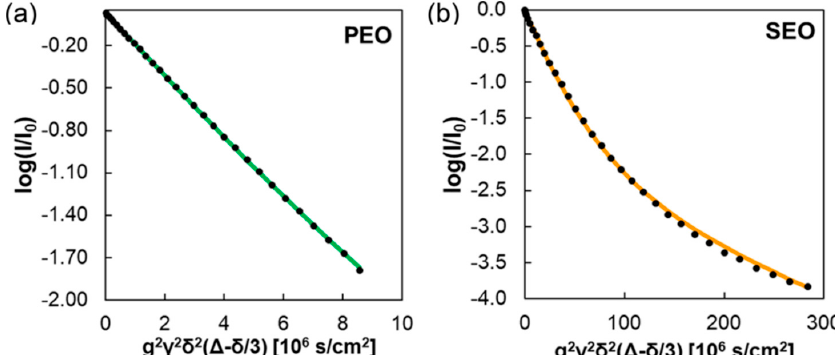
Figure 6. PFG-NMR signal attenuation of 19 F seen in ( a ) PEO(5)/LiTFSI at r = 0.06 and ( b ) SEO(16 − 16)/LiTFSI at r = 0.18 [65]. Reprinted with permission from [65]. Copyright 2018 American Chemical Society.